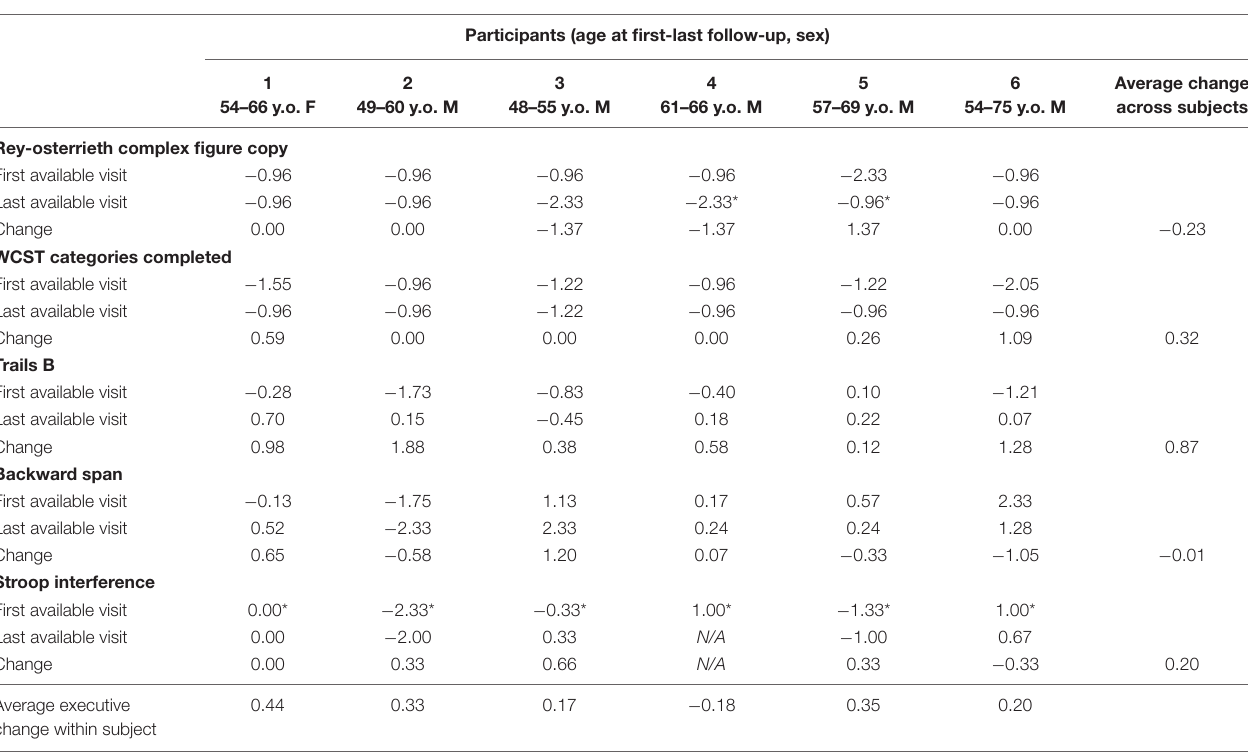
TABLE 6 | Executive performance of the